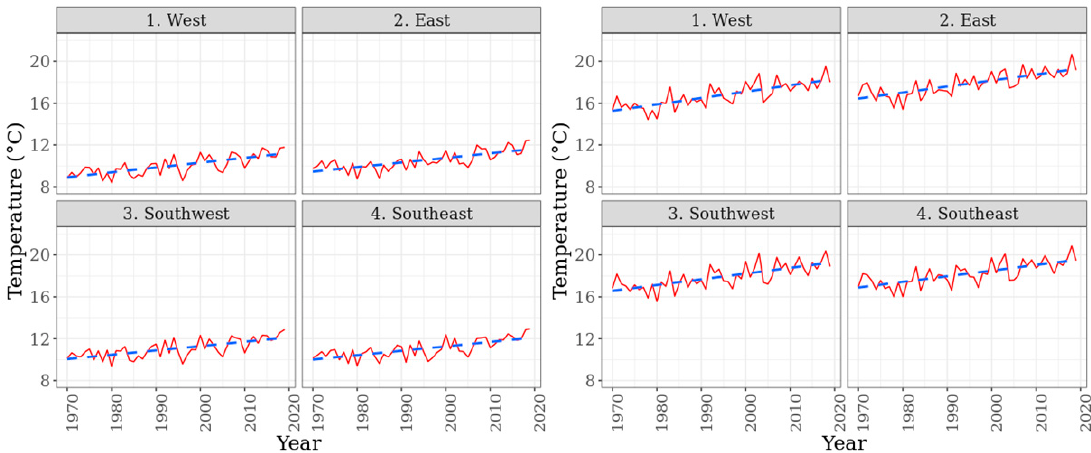
Figure 7. Annual ( left ) and seasonal * ( right ) mean air temperature values in the four investigated regions (1970–2019). * Calculated for the vegetation period of maize (May–August).